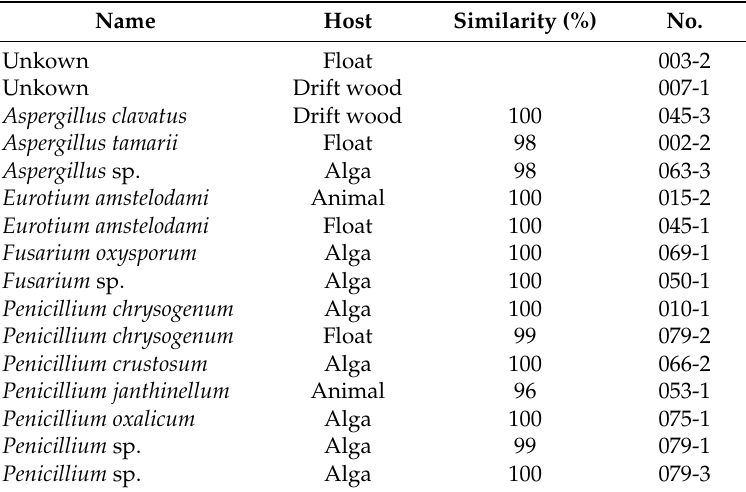
Table 1. Fungal strains isolated from marine